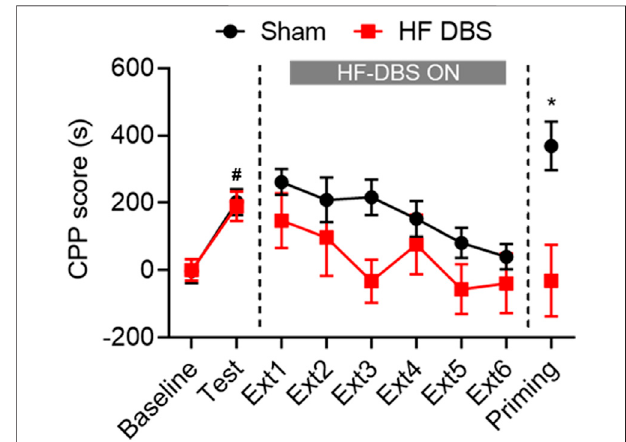
FIGURE 2 | HF DBS of the SNr facilitated extinction and prevented the reinstatement of methamphetamine-induced CPP. Methamphetamine (1 mg/kg) induced a signi fi cant preference for the drug-paired side in both groups, and sham DBS or HF DBS (130 Hz, 150 μ A, 100 μ s) was then applied to the SNr during each of the drug-free extinction sessions (15 min). HF DBS caused a signi fi cant decrease in CPP scores compared with the sham DBS. After full extinction, a priming injection of methamphetamine (1 mg/kg)wasgiventotheshamDBSandHFDBSgroups,andonlythesham DBS group, but not the HF DBS group, showed reinstatement of drug- seeking behavior. Data are shown as mean ± SEM. # p < 0.05 compared with baseline (sham and HF DBS), * p < 0.05 compared with HF DBS. Sham DBS: n (cid:2) 8; HF DBS: n (cid:2)